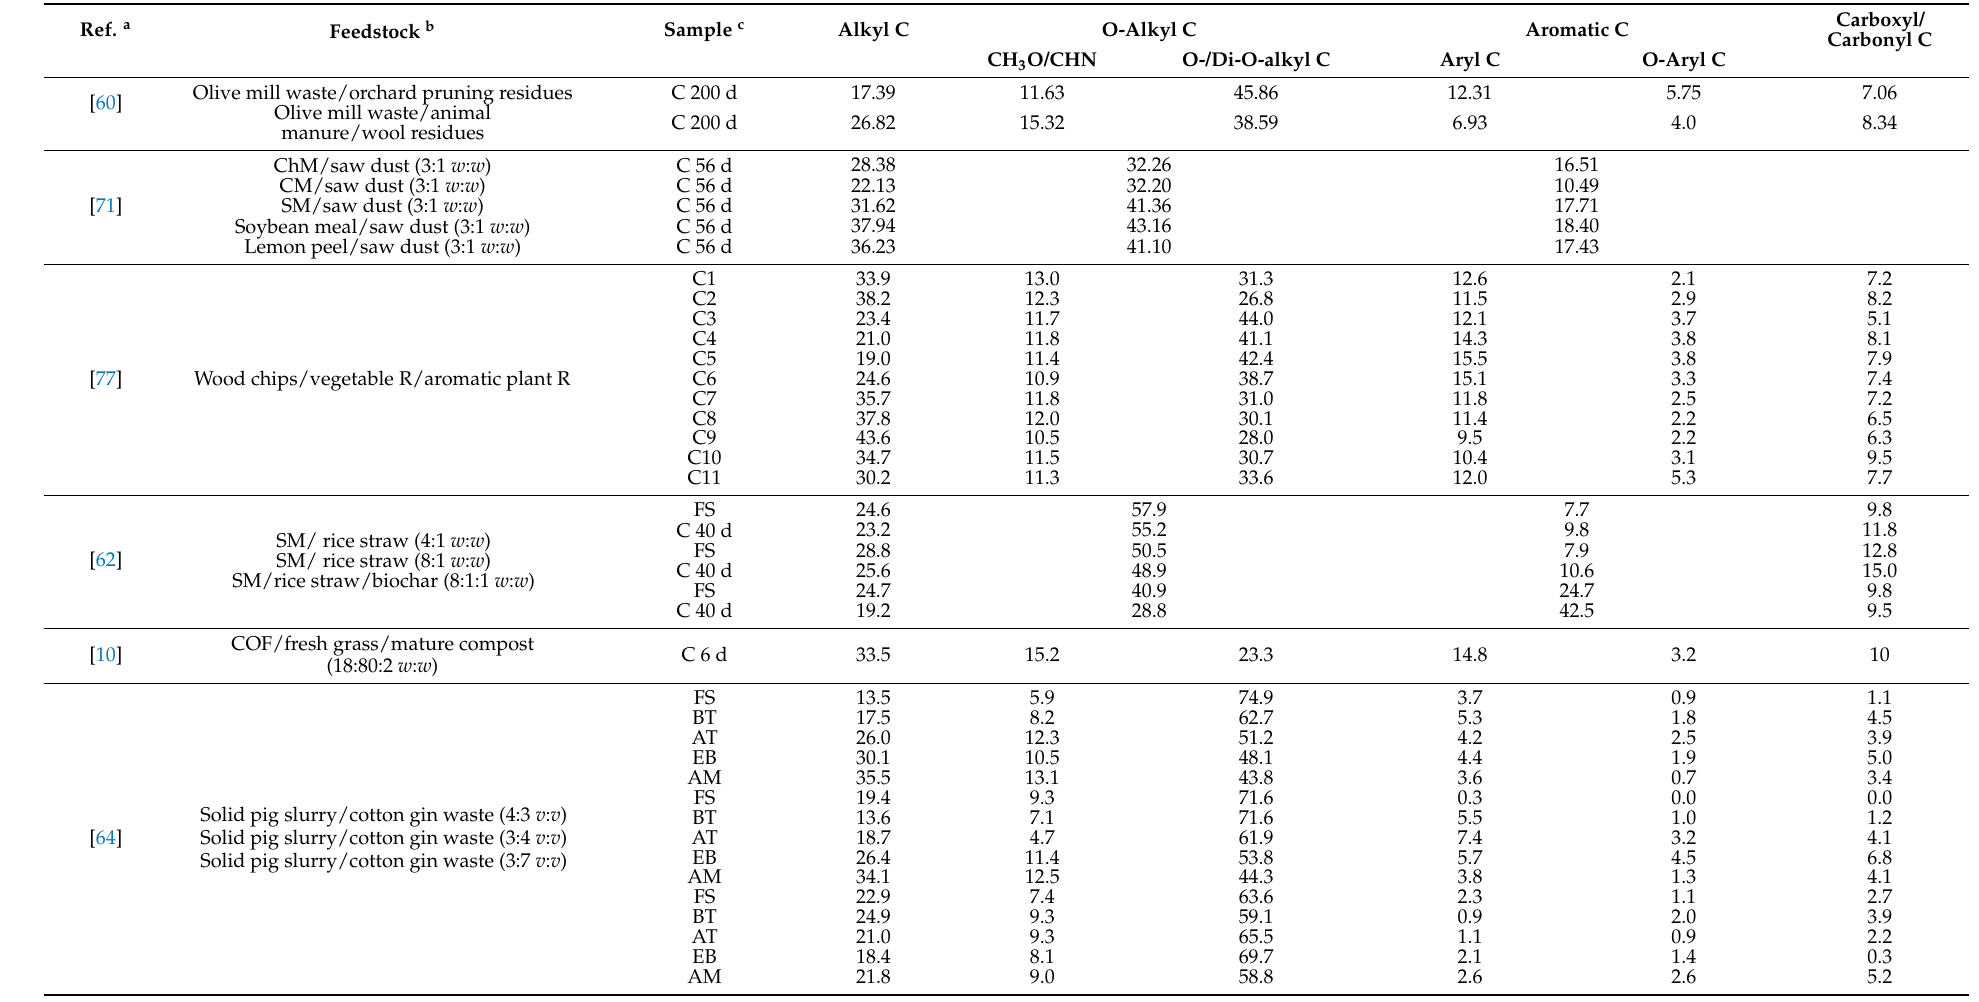
Table 2. Relative areas (% of total area) of the different regions of 13 C CP-MAS NMR spectra for compost samples and corresponding feedstocks reported in the